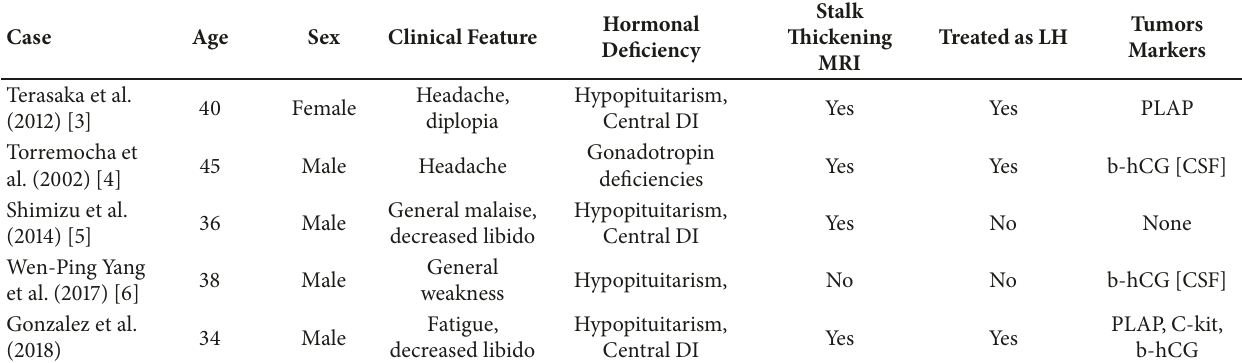
Table 2: Cases of germinomas with similar clinical features described in the literature.